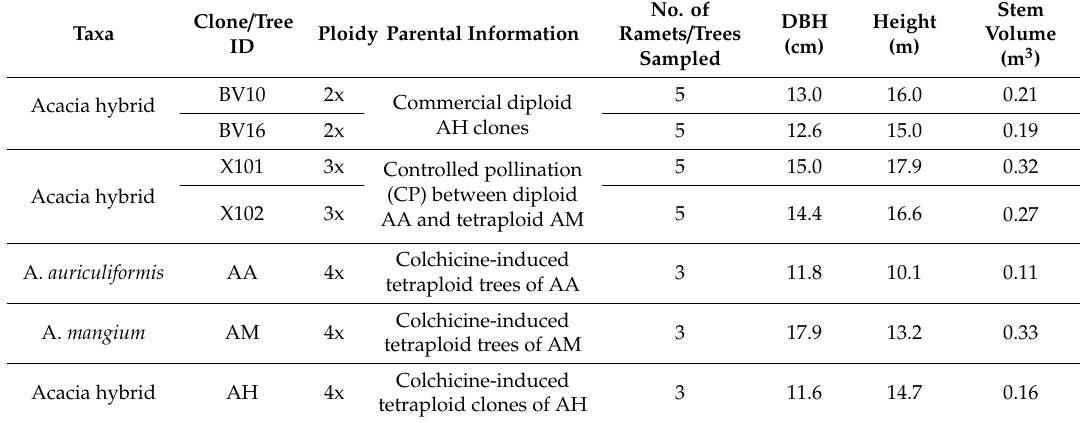
Table 1. Polyploid materials at 3.8 years old used in the